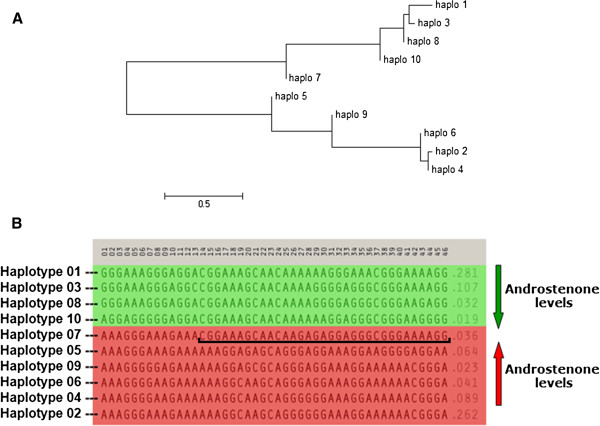
Phylogeny of the 10 haplotypes. (A) Phylogenetic tree for the 10 most frequent haplotypes and (B) the 10 most frequent haplotypes across all populations ordered according to the phylogenetic tree and colored according to their effect on androstenone level. The underlined region indicates similarity between haplotype 7 and low-androstenone haplotypes.